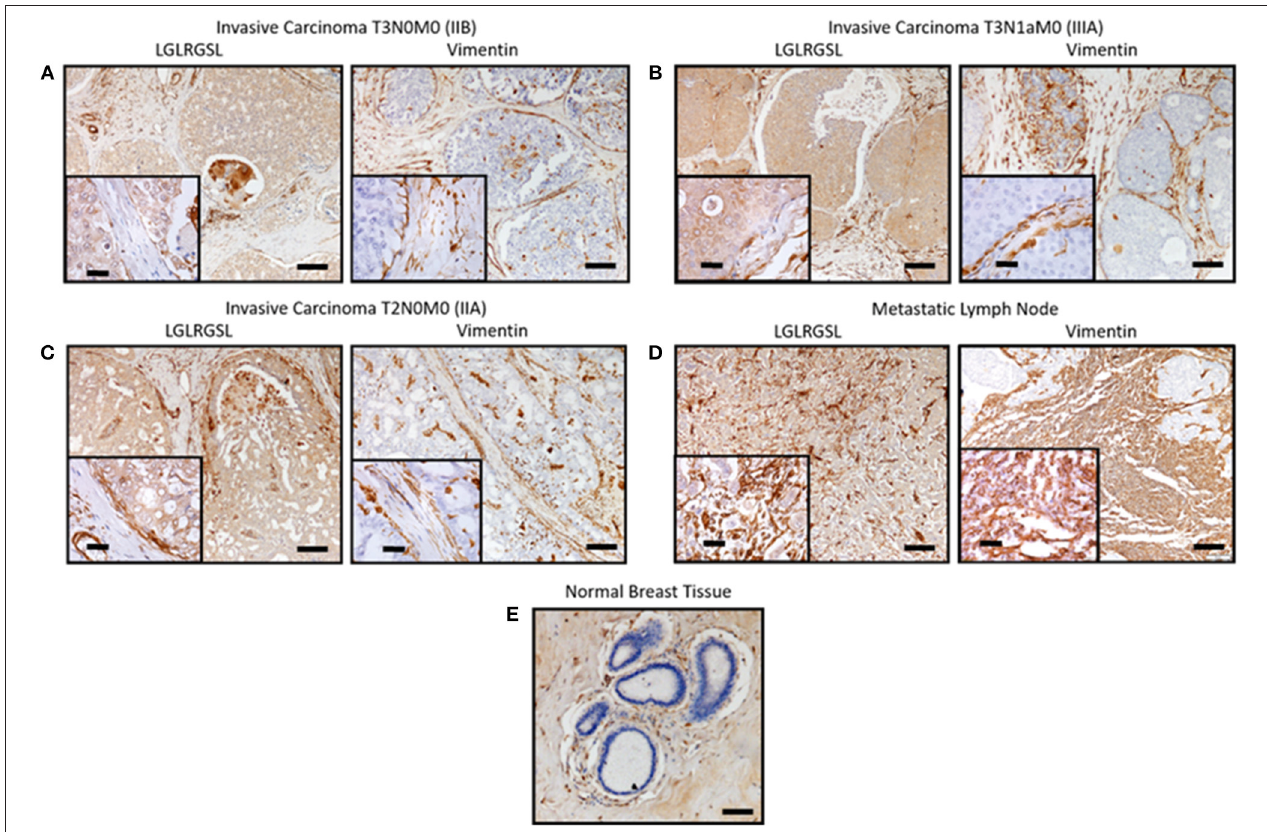
FIGURE 5 | Ex vivo phage binding to human breast cancer tissue microarray. Tissue microarray of invasive ductal carcinoma and adjacent normal tissues were incubated with 10 10 pfu of LGLRGSL phage or Vimentin antibody and then subsequently with M13-pIII antibody for phage and secondary peroxidase antibody for phage and Vimentin, imaged with a digital light microscope. Strong brown staining of the phage and Vimentin was observed in invasive ductal carcinoma sections (A–C) and metastasis in lymph nodes, (D) while no staining was observed in normal breast tissue, (E) Scale Bar is 40 and 10 µ m for the